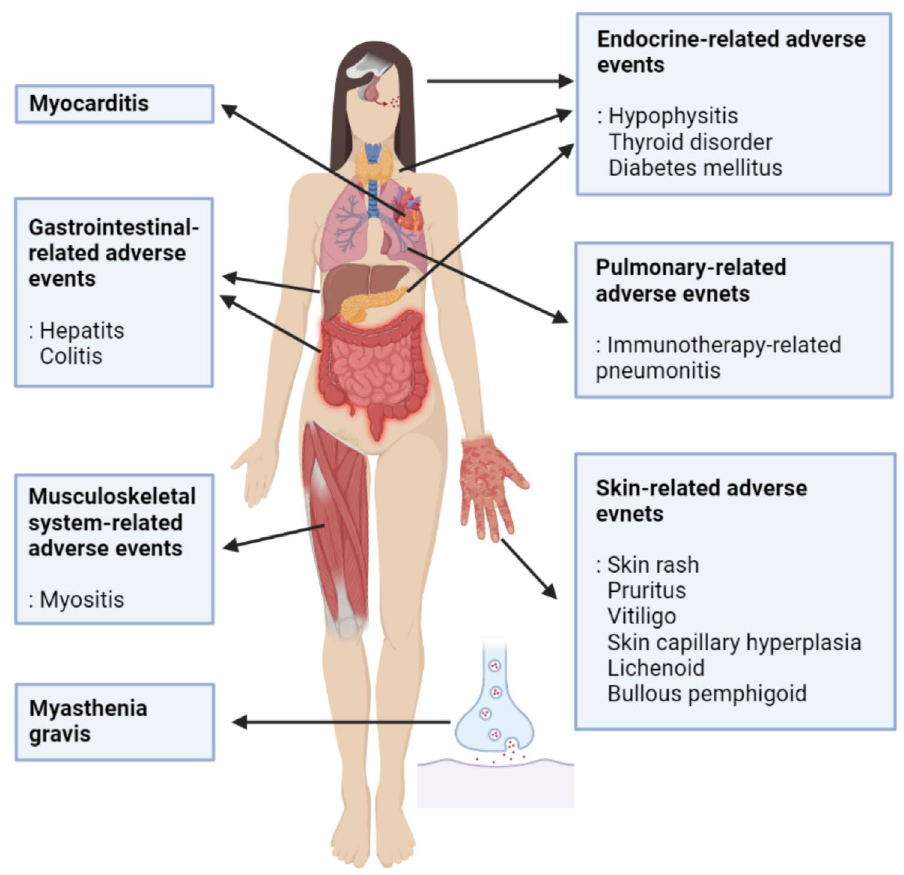
Figure 3. The organ-specific toxicities that can be induced by ICI therapy.